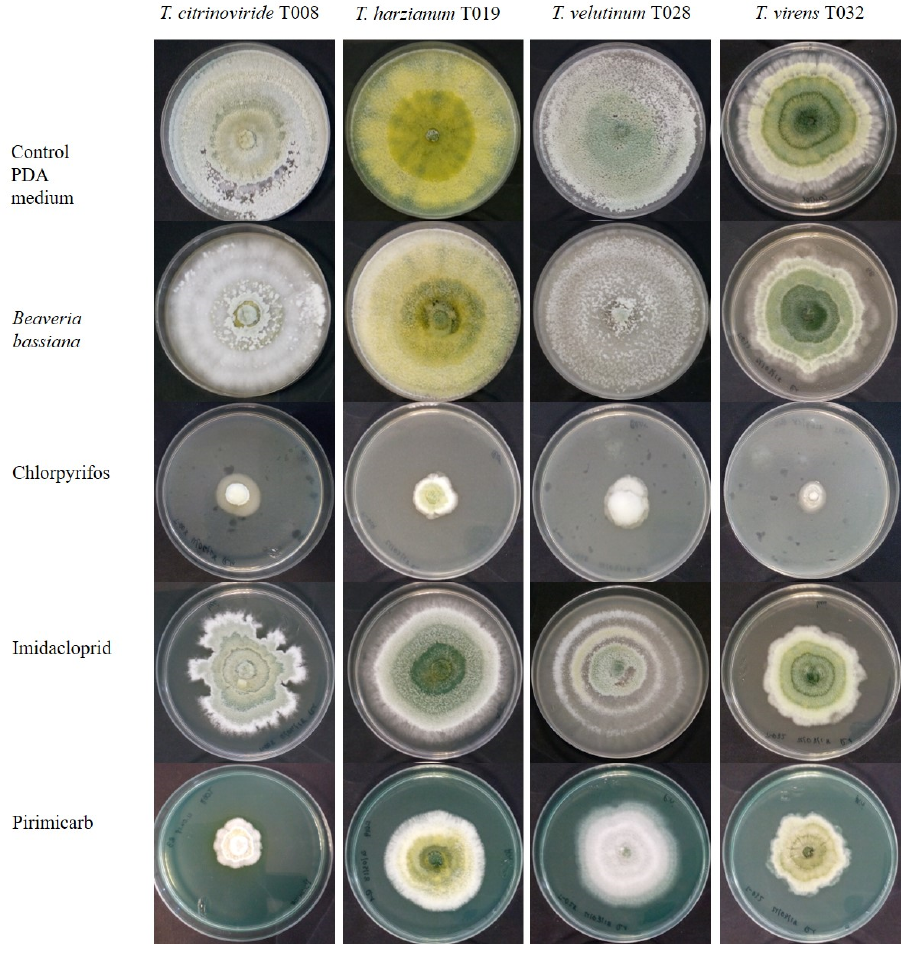
Figure 5. Growth of autochthonous Trichoderma strains in medium with synthetic insecticides and the entomopathogenic fungus Beauveria bassiana at day 5 after inoculation.